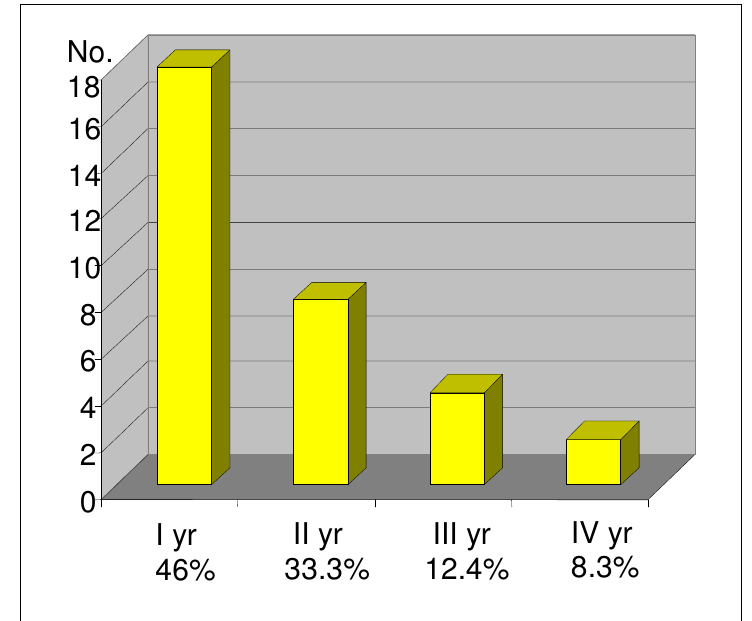
FIGURE 1. Conversion rate per year in the MCI group.